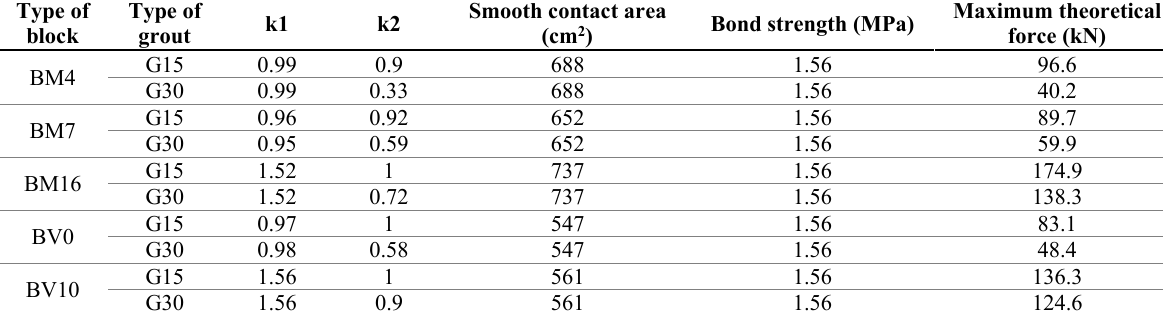
Table 7. Maximum theoretical force.